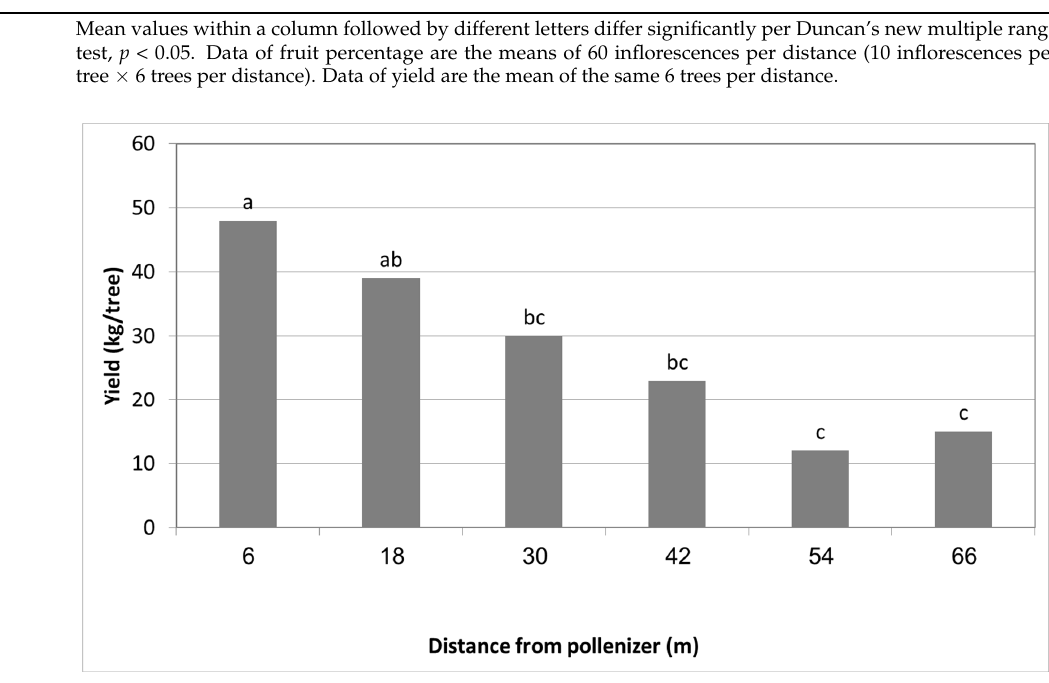
Table 2. The effect of the pollinizer HL on fruit set and yield of MA trees at different distances, Almagor 2016–2017.